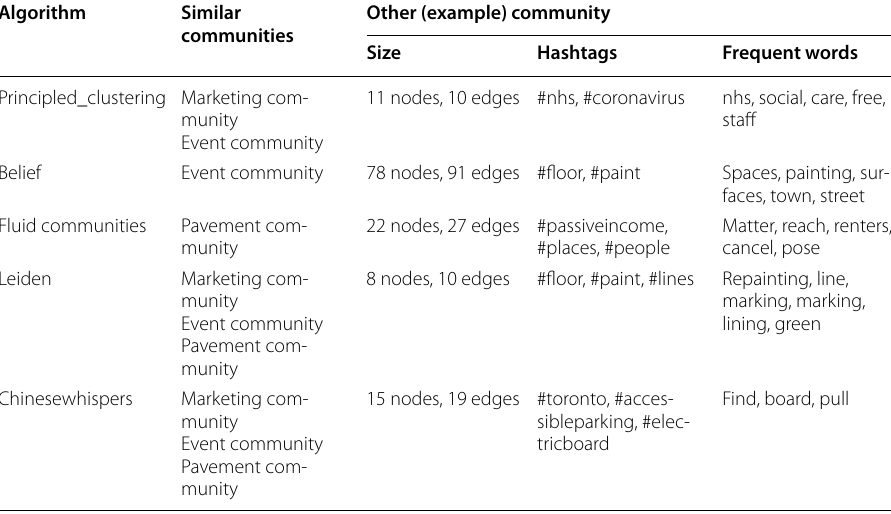
Table 10 Comparison with other community detection algorithms